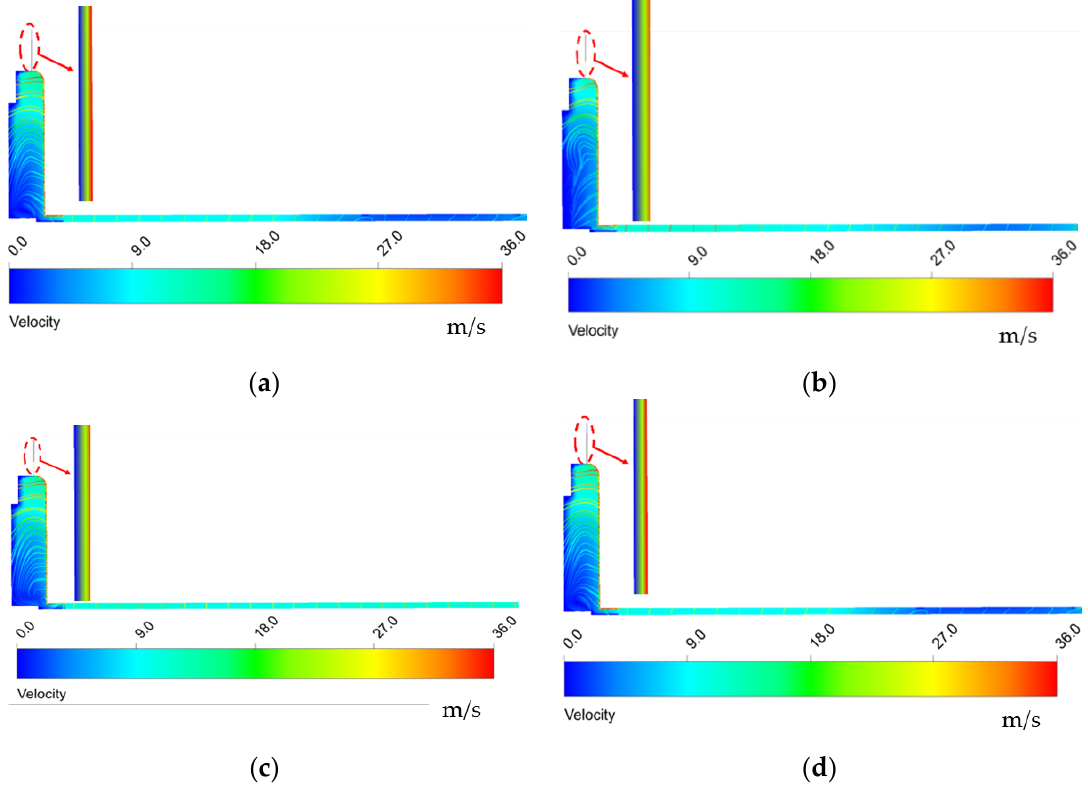
Figure 10. Particle trajectory and velocity distribution in the vertical section of the band under different guide vane opening. ( a ) 10°, ( b ) 20°, ( c ) 25°, ( d ) 30°.